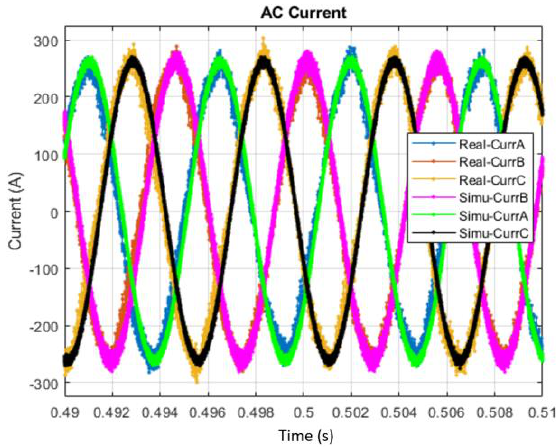
Figure 21. Case 2: speed = 5382 RPM and torque = 24.6 Nm.